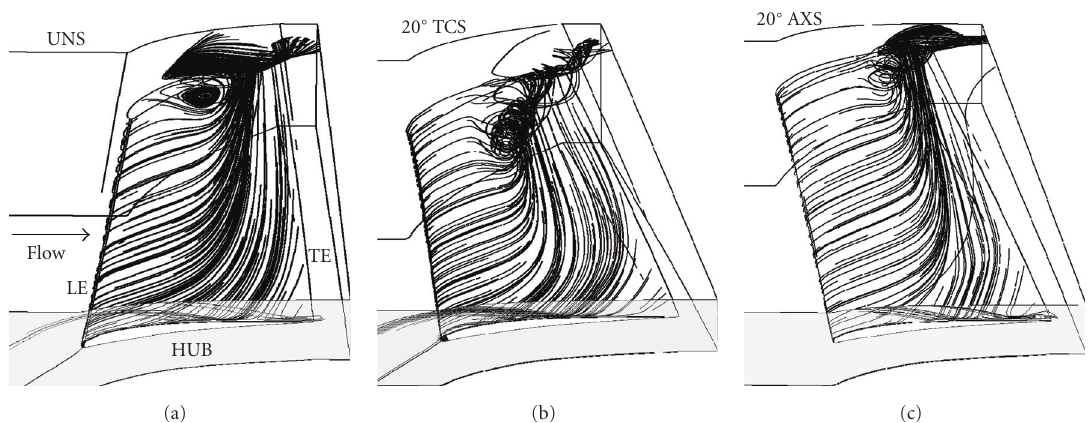
Figure 6: Streamline patterns in the suction surface flow separated regions in various